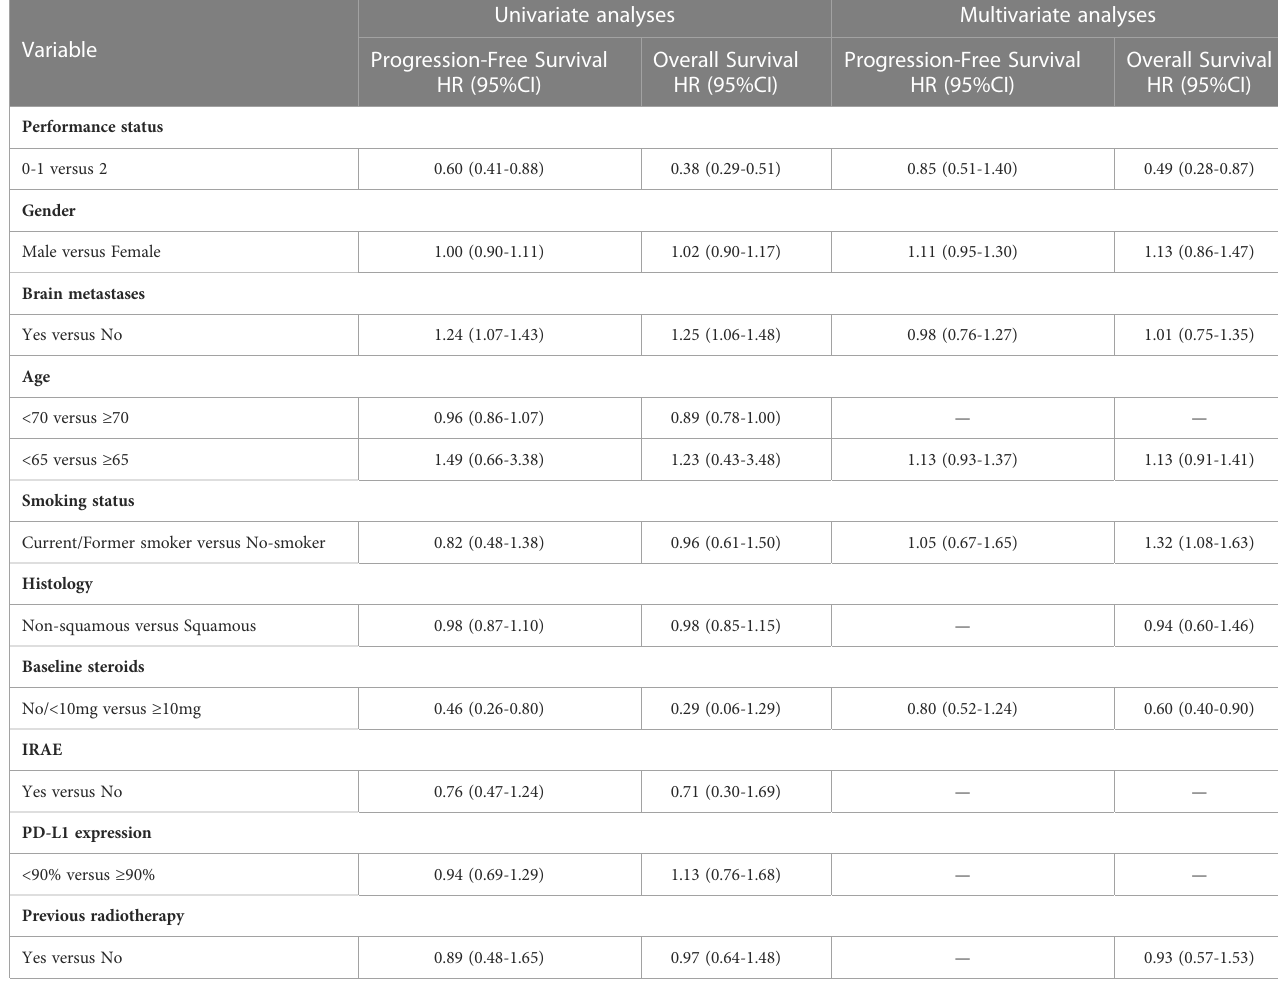
TABLE 3 Univariate analyses and multivariate